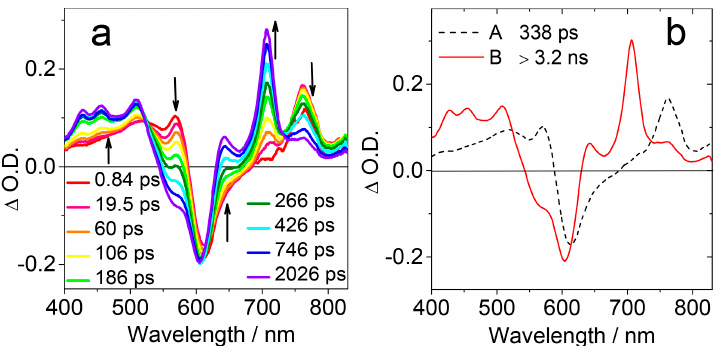
Figure 5. ( a ) Femtosecond transient absorption spectra of NDI-TEMPO at different delay times ( λ ex = 610 nm). ( b ) Evolution associated difference spectra (EADS) of NDI-TEMPO obtained by global fitting and target analysis of the fs-TA spectral data. c = 2.5 × 10 − 4 M in toluene, 20 ◦ C. Reproduced with permission from reference [41], copyright 2018,